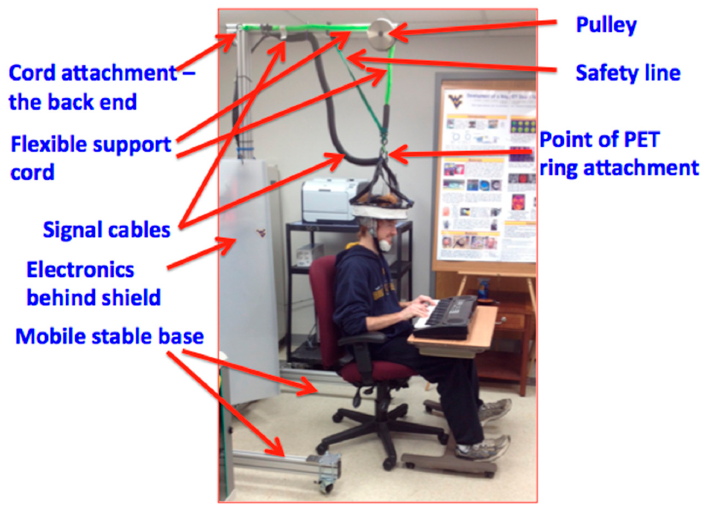
Figure 3. More details of the Generation 0 support mechanics.